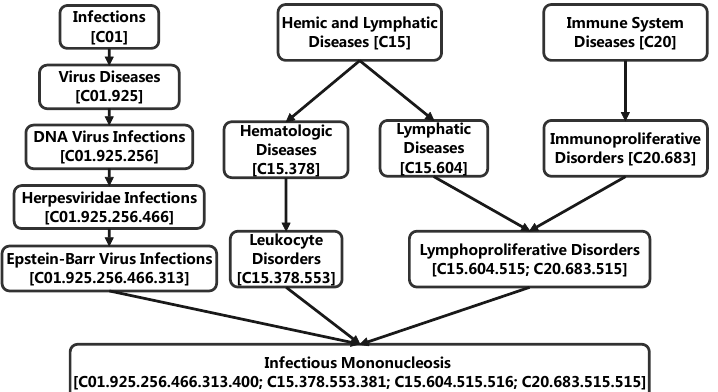
Figure 2. The directed acyclic graph(DAG) of infectious